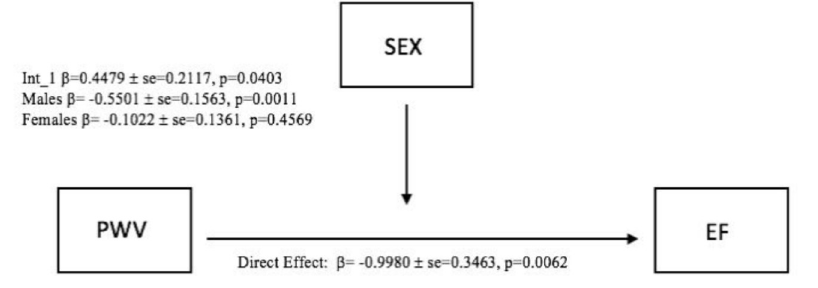
Fig 3. Moderation effect (PWV � SEX) on